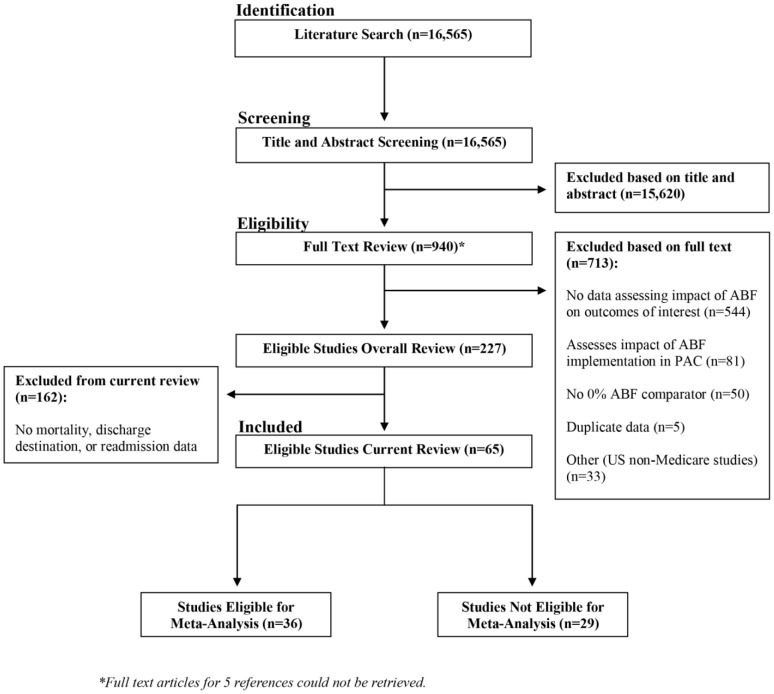
Prisma flow diagram.